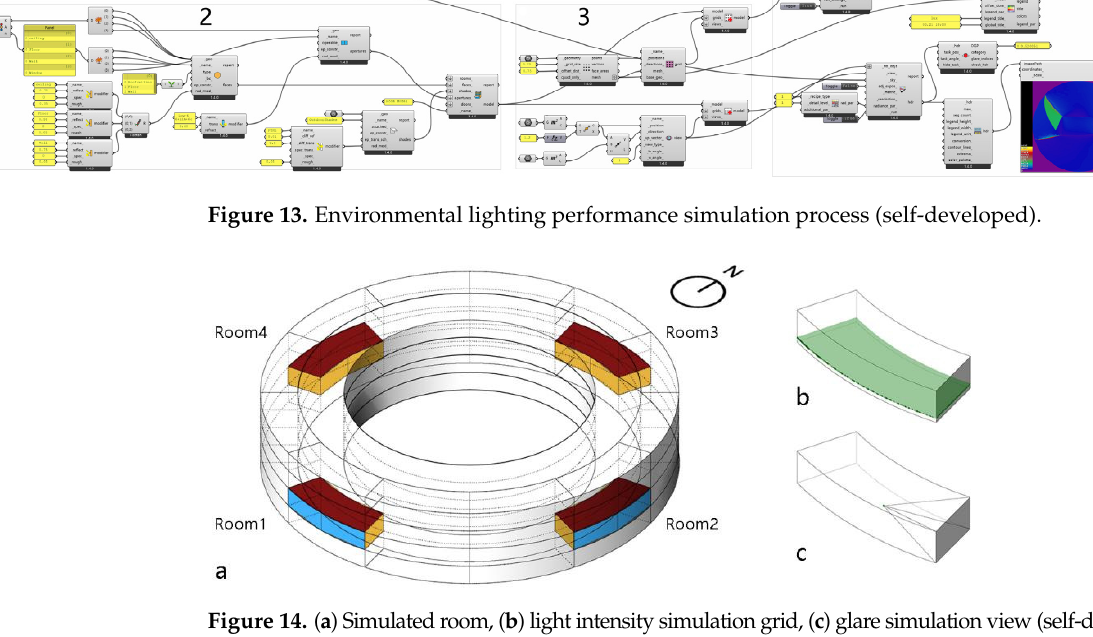
Figure 14. ( a ) Simulated room, ( b ) light intensity simulation grid, ( c ) glare simulation view (self-developed). Table 4. Parameter values for simulated rooms and shading objects